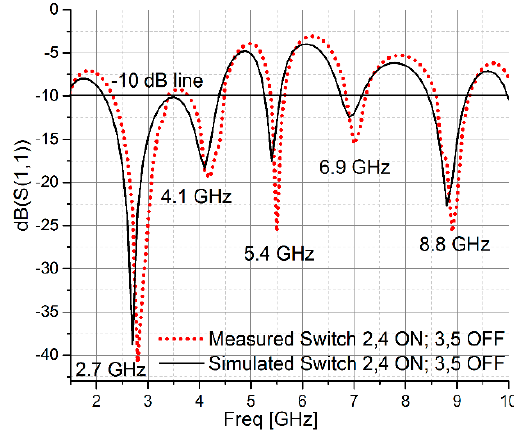
Figure 13. Measured and simulated S 11 for switches 2 and 4 ON, switches 3 and 5 OFF.